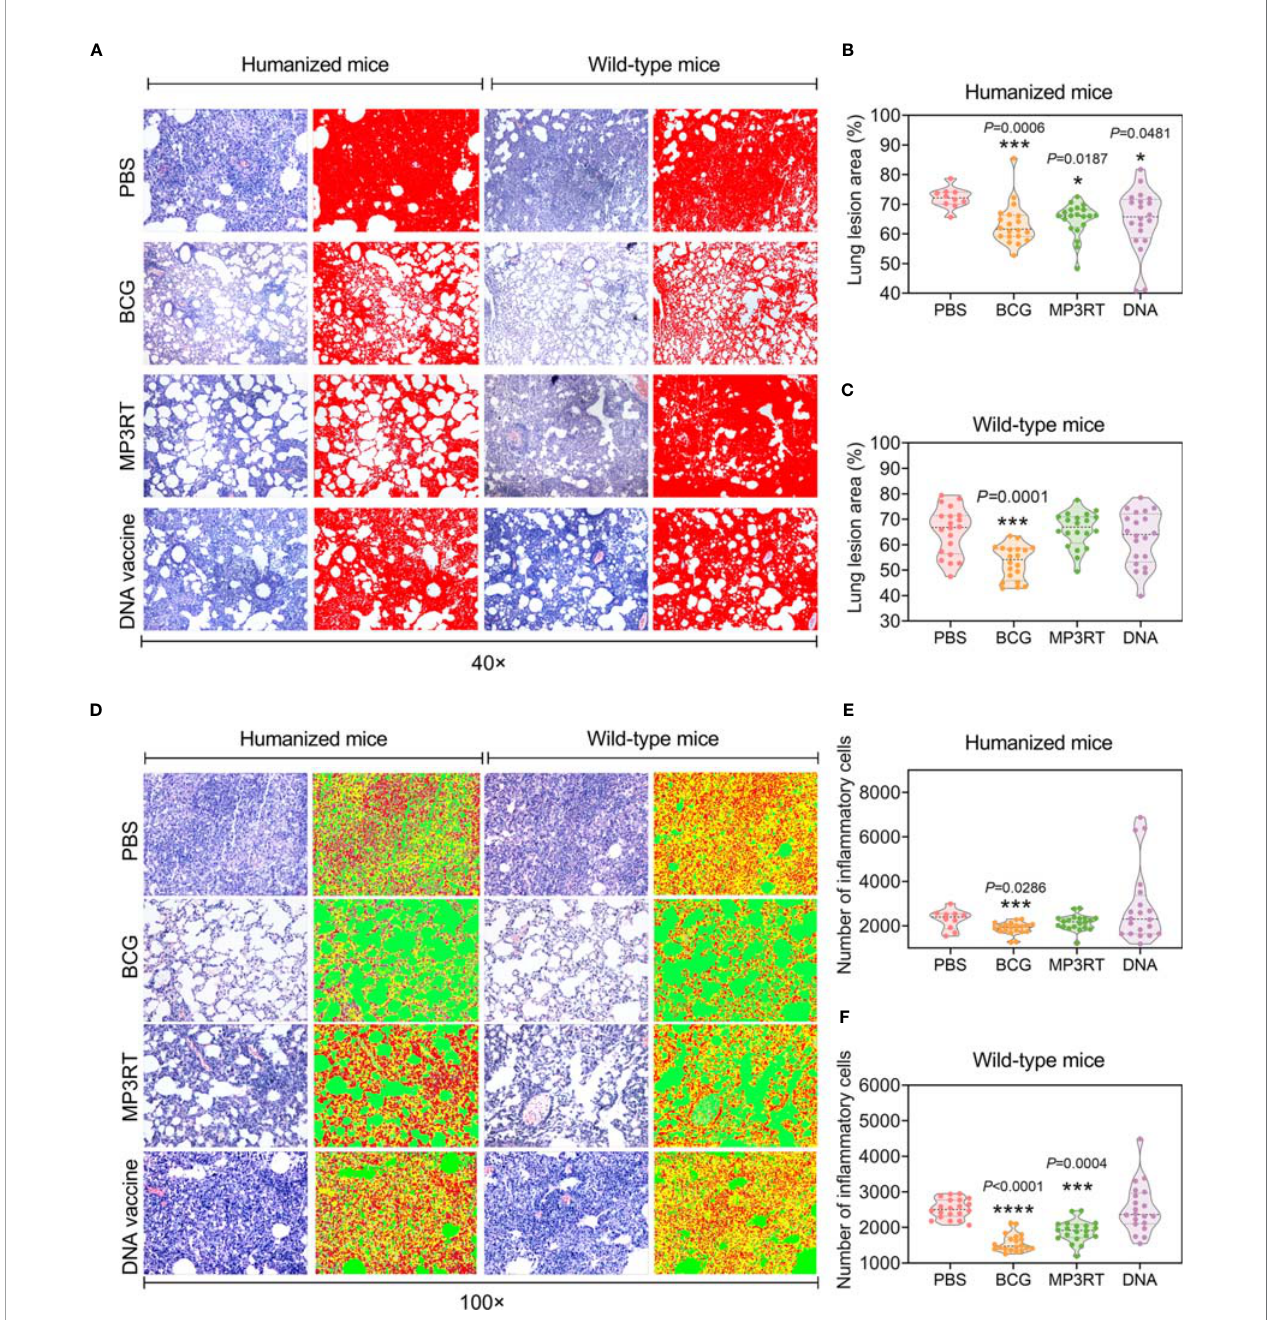
FIGURE 5 | Histopathological characteristics of the lung from mice vaccinated with the MP3RT vaccine. The right lobe of the lung and the rest of the liver obtained from humanized or wild-type mice were used to perform H&E staining and analyzed with software. Each tissue section ’ s pathological changes were observed using a microscope with original magni fi cation times of 40 × (A) and 100 × (D) . The lung lesion area of tissue section obtained from humanized (B) or wild-type mice (C) was marked as red and determined using Image-Pro Plus software. The in fl ammatory cells of the lung tissue section obtained from humanized (E) or wild-type mice (F) were determined using Image-Pro Plus software. The in fl ammatory cells were marked in red, alveoli were marked in green, and alveolar walls were marked in yellow. Observations and calculations were done independently by two researchers, and their calculation results were merged. Five tissue sections of each mouse were randomly selected for continuous observation and then took the average value. The results were statistically analyzed with one-way analysis of variance (ANOVA) or Kruskal-Wallis test according to the data normality and homogeneity of variances. All data were shown as mean + SEM ( n = 10 in humanized mice vaccinated with PBS and n = 20 in other groups). P < 0.05 was considered signi fi cantly different. * P < 0.05; *** P < 0.001; **** P <